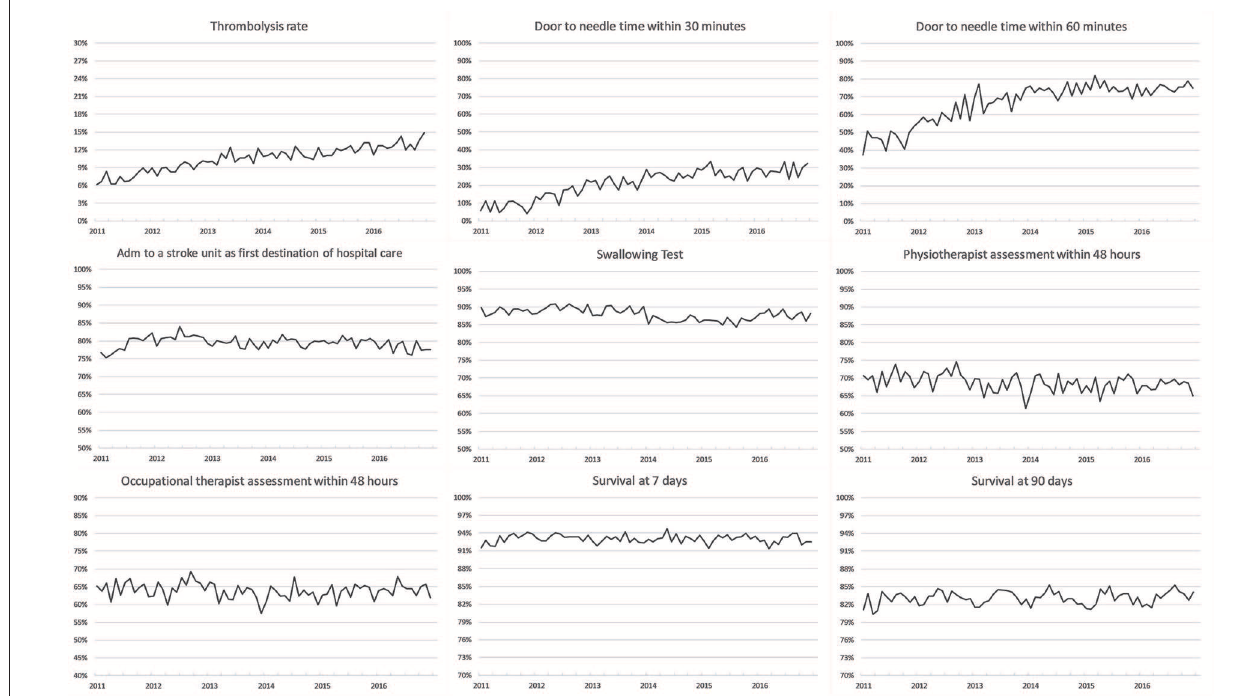
FIGURE 5 | Unadjusted monthly longitudinal analyses.